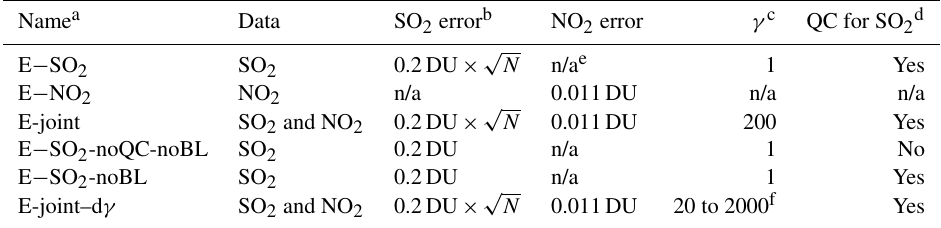
Table 1. Different experimental design for using OMPS SO 2 and NO 2 to constrain corresponding emissions over China for October 2013.